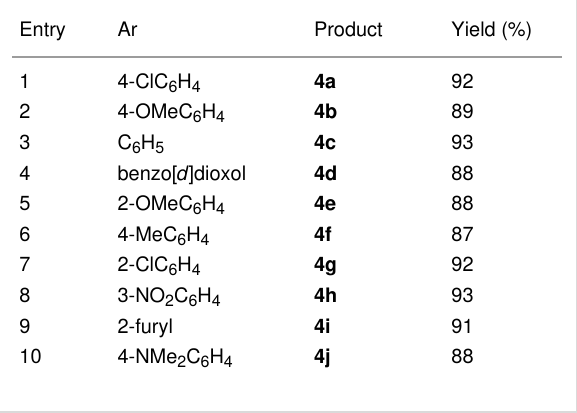
Table 1: Microwave three-component synthesis of triazines 4a – j